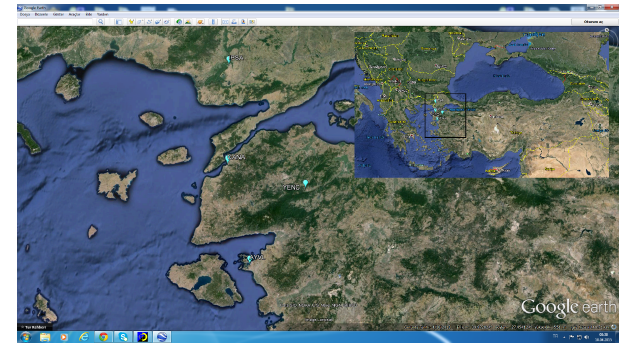
Figure 3. The CORS-TR stations